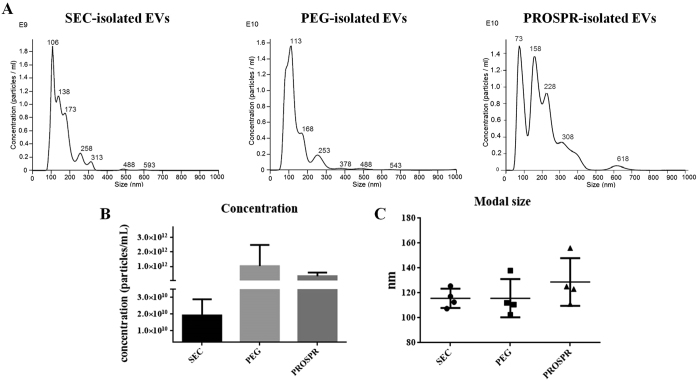
EVs characterization by Nanoparticle Tracking Analysis (NTA).(A) Representative size distribution profiles of EVs isolated by SEC, PEG or PROSPR precipitation. (B) Concentration (particles/mL) and (C) modal size (nm) of EV samples according to NTA measures. The median +/−SD is reported for four independent experiments from four individual samples carried out in parallel with each method.